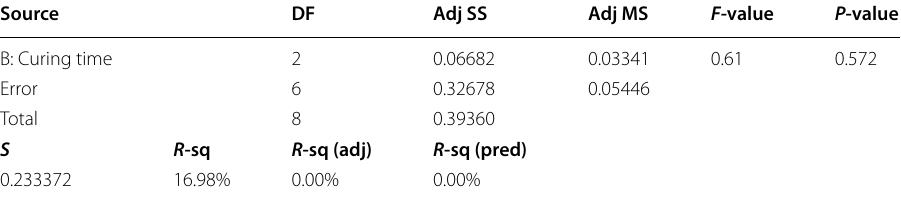
Table 6 One-way analysis of variance for the curing time